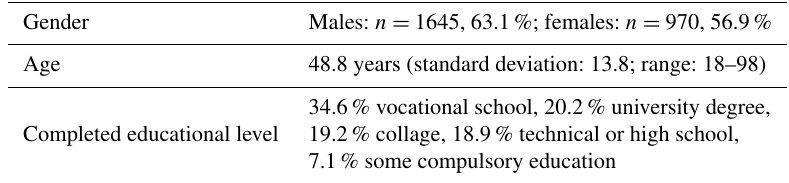
Table 3. Sociodemographic characteristics of participants in the field experiment.